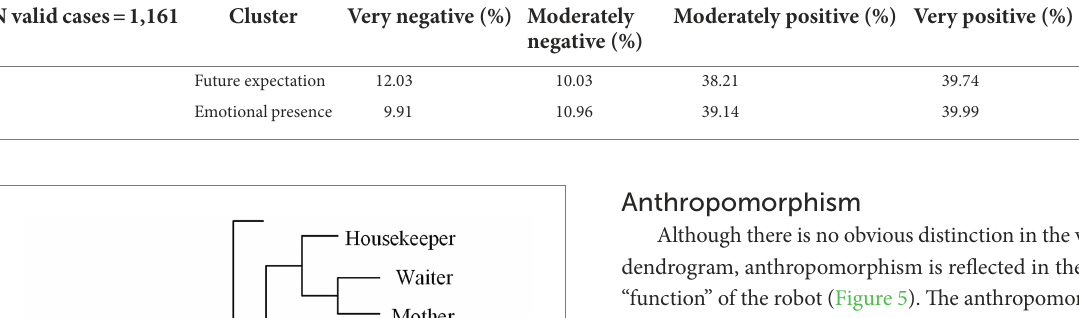
TABLE 4 Sentiment analysis of emotional dimension.